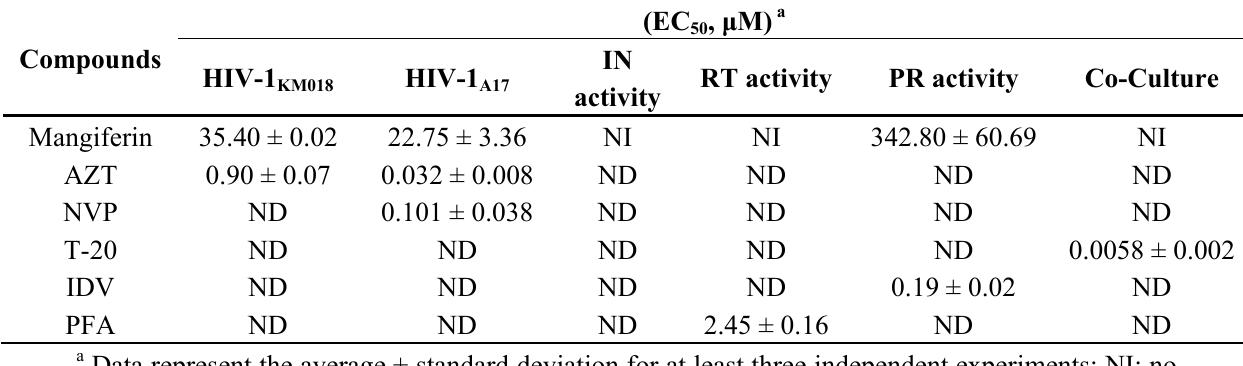
Table 1. Inhibitory effects and mechanism of action of mangiferin.